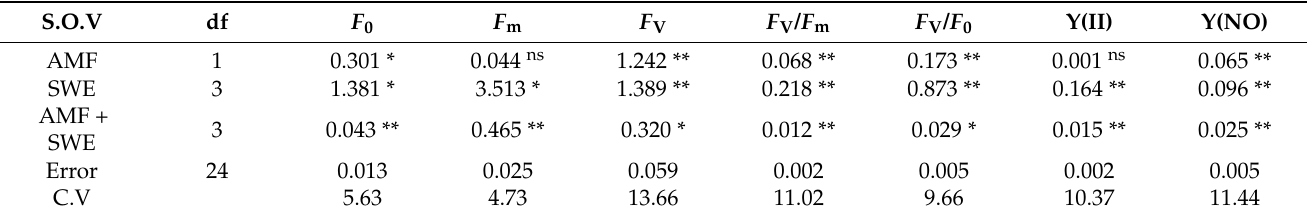
Table 3. Analysis of variance (ANOVA) for the effects of arbuscular mycorrhiza fungi (AMF) inocula- tion and seaweed extract (SWE) foliar spray on some physiological traits of the lettuce plant.